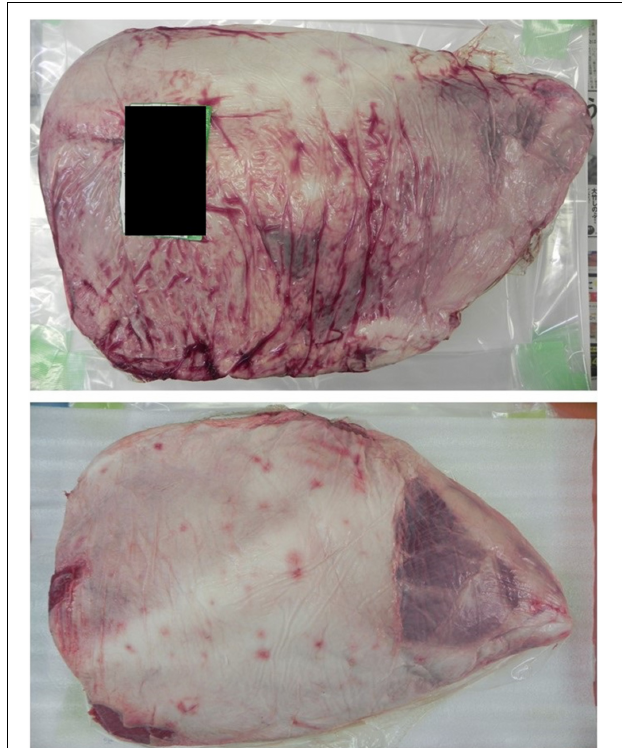
FIGURE 1 | The type of beef (beef leg) used in this